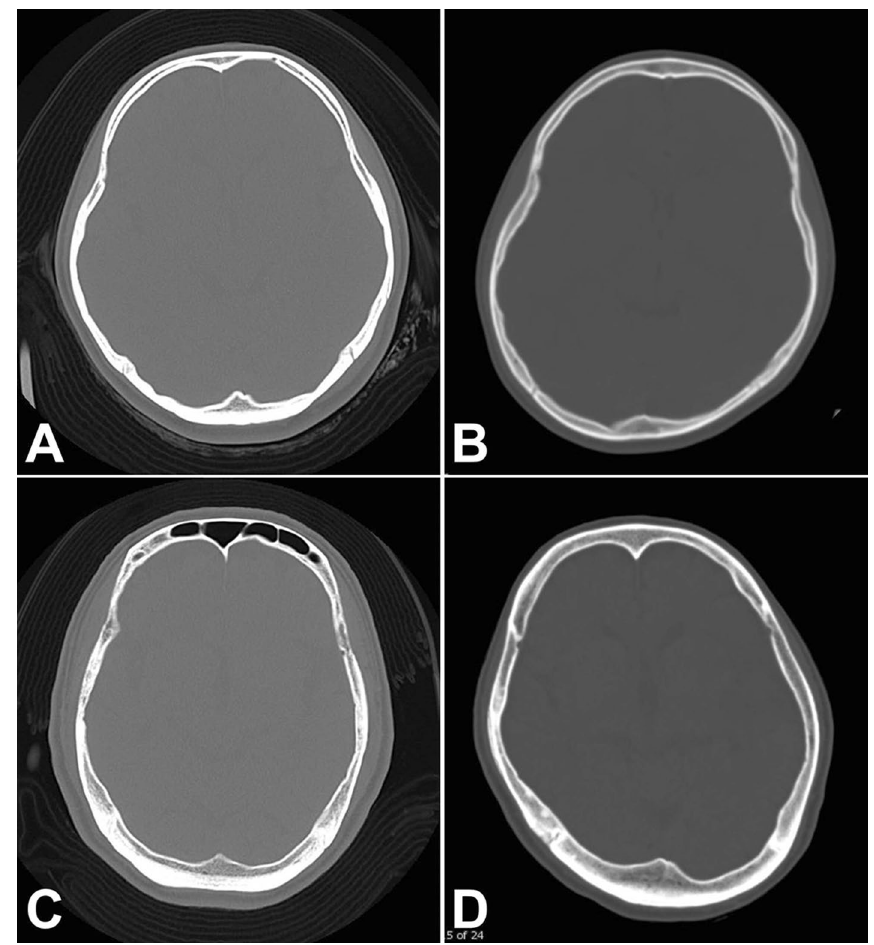
Figure 4. Representative computed tomography scan findings. An axial computed tomography scan of the head with a bone window from head injury ( A ), moyamoya disease ( B ), cervical internal carotid artery stenosis ( C ), and depression ( D